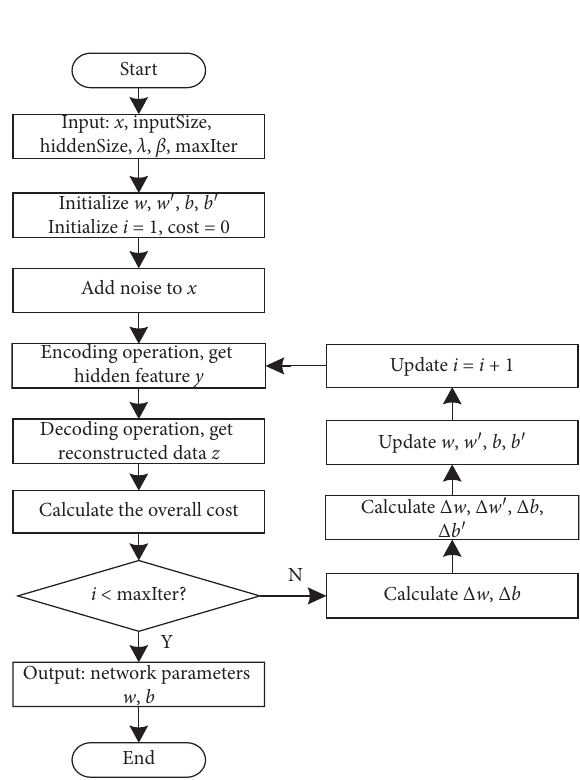
Figure 2: Algorithm flow of training encoder.